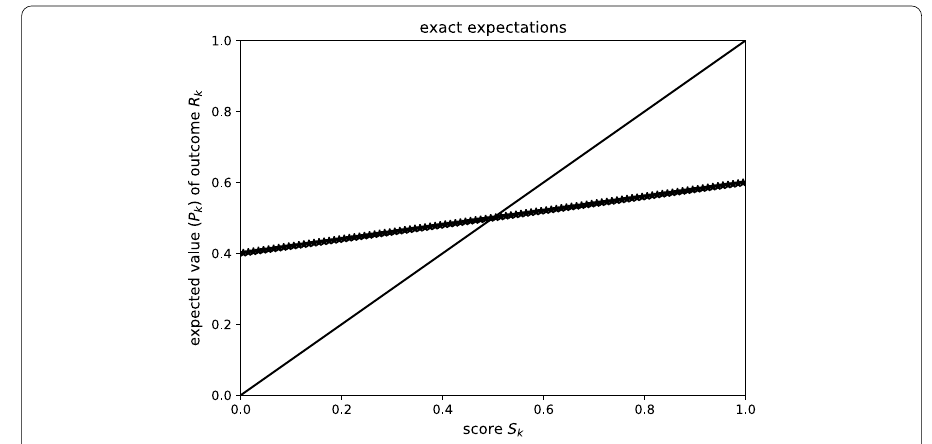
Fig. 33 Ground-truth reliability diagram for Fig.